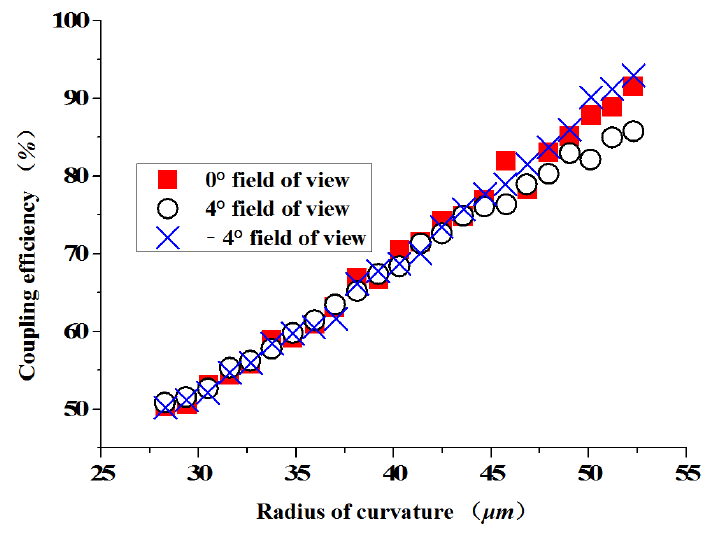
Figure 5. The radius of curvature of the micro lens and the coupling efficiency.